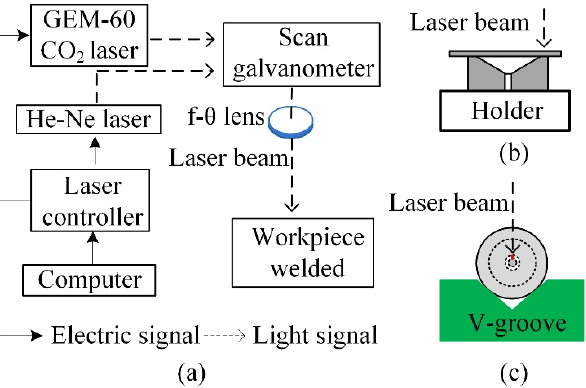
Figure 2. Welding optical path system. ( a ) schematic block diagram; ( b ) fixture of diaphragm; and ( c ) fixture of ferrule.